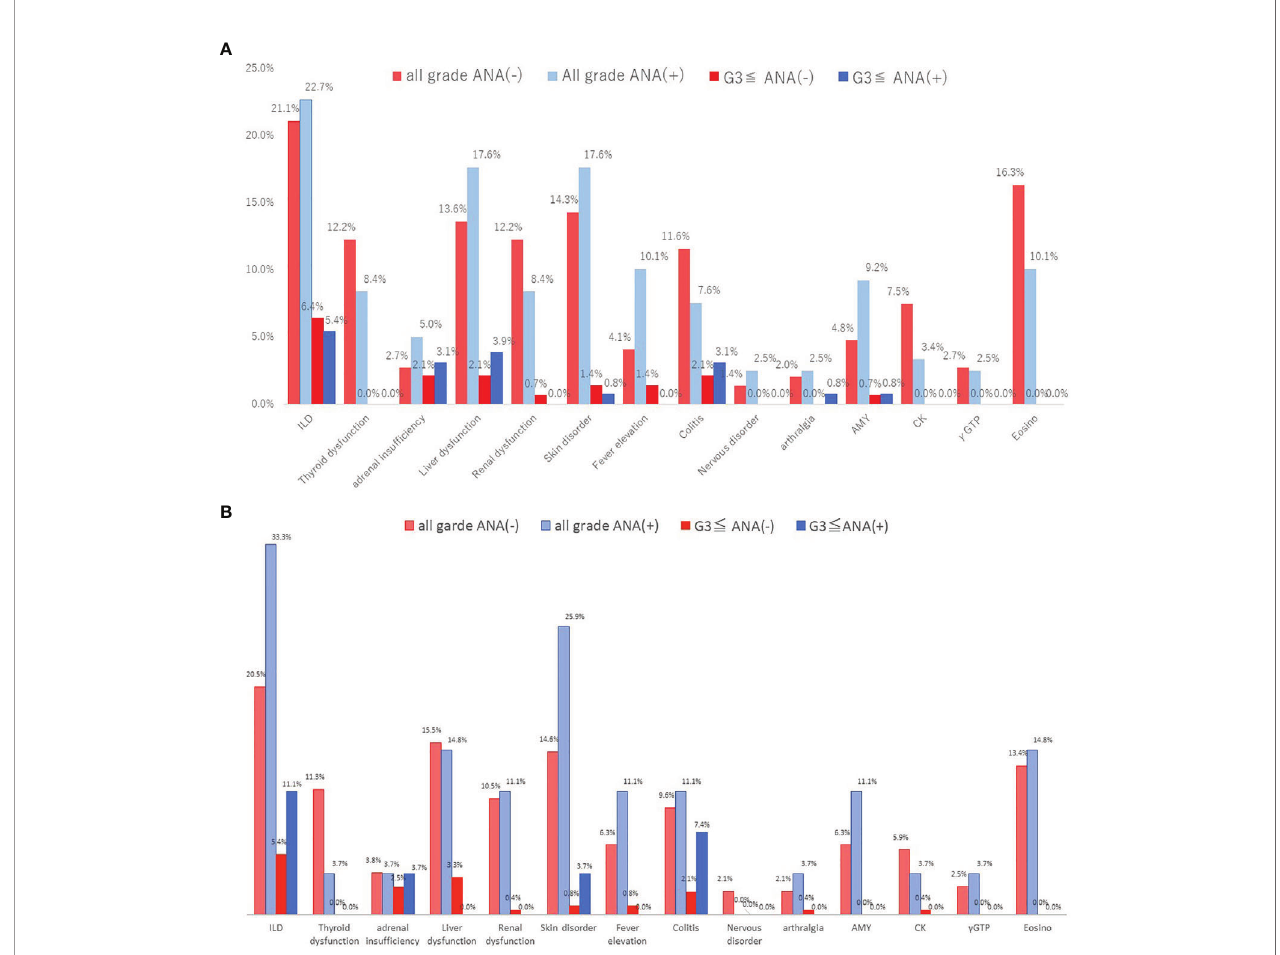
FIGURE 3 | Immune-related adverse events between ANA-positive and ANA-negative patients (cutoff of 1:40) or high and low ANA (cutoff of 1:80). The irAEs were listed at frequency 2% or more in either group. (A) When a positive ANA cutoff of 1:40 was used, (B) when a positive ANA cutoff of 1:80 was used. irAEs, immune- related adverse events; AMY, amylase; CK, creatine kinase; g GTP, g -